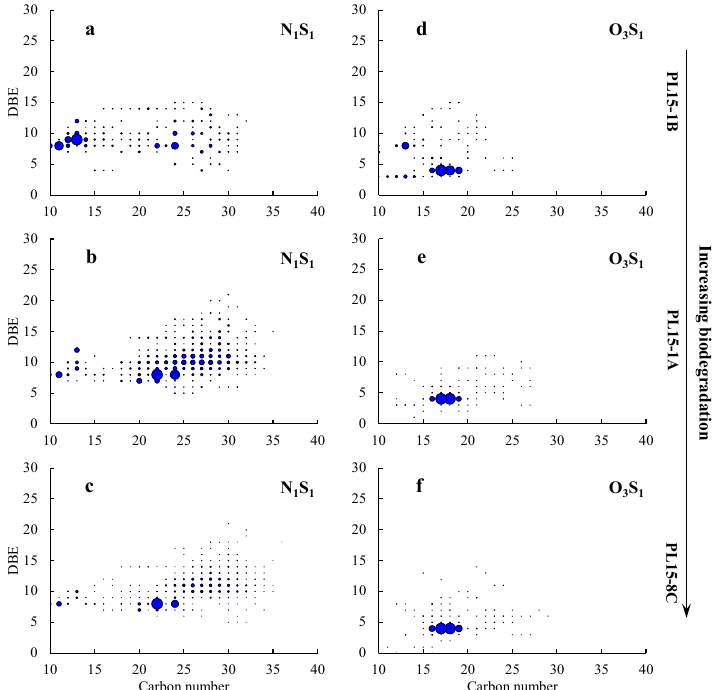
Figure 7. Iso-abundance plots of DBE versus carbon number of N 1 S 1 and O 3 S 1 classes in the crude oils. ( a – c ) show the N 1 S 1 class for the PL15-1B, PL15-1A, and PL15-8C oils, respectively, and ( d – f )